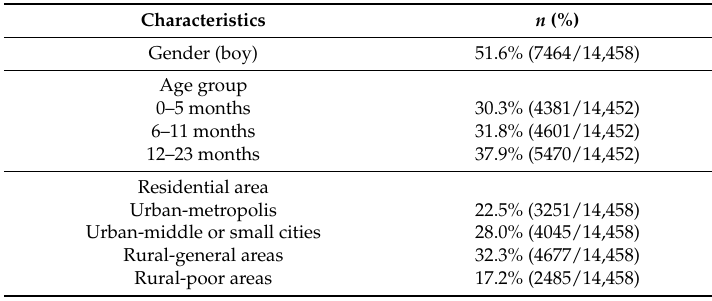
Table 1. General characteristics of the